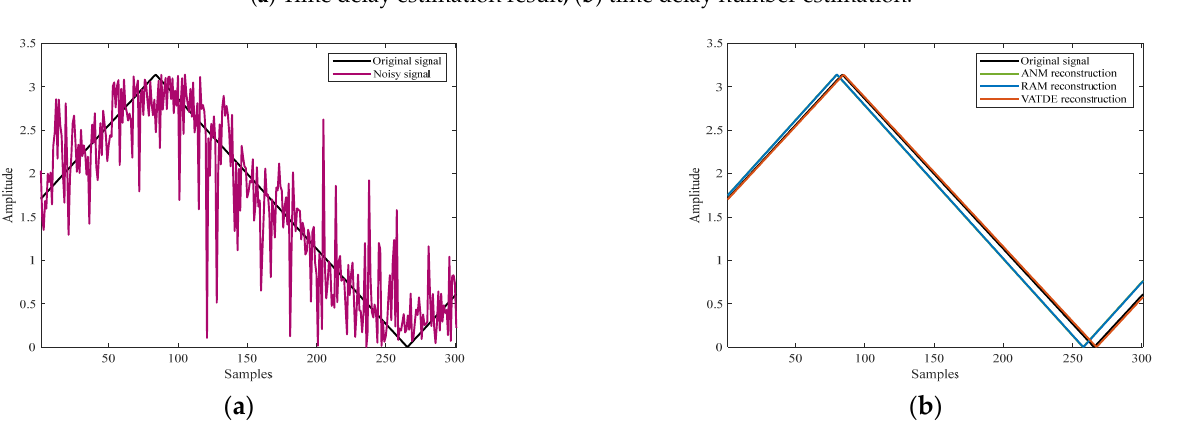
Figure 1. Single time delay estimation performance of different algorithms in the case of SNR 10 dB. ( a ) Time delay estimation result, ( b ) time delay number estimation.